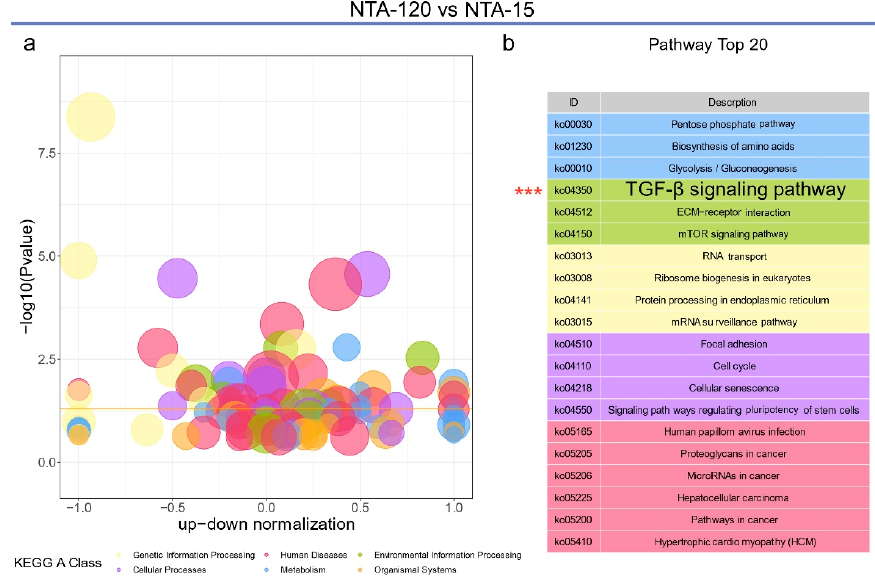
Figure 7. Analysis of differential genes within NTA-120 vs. NTA-15. ( a ) Bubble chart of the KEGG pathway enrichment analysis of NTA-60 vs. NTA-15. ( b ) The detailed list of Top 20 KEGG enrichment pathways. The asterisks highlight the TGF-signaling